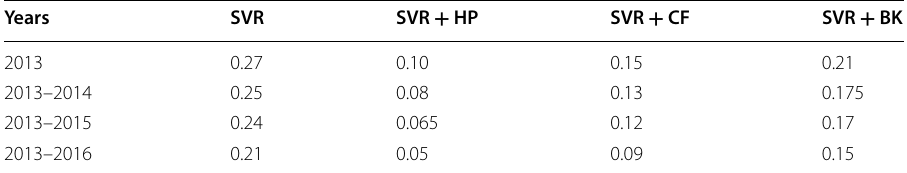
Table 3 MAPE (Error rate) of the predictive models